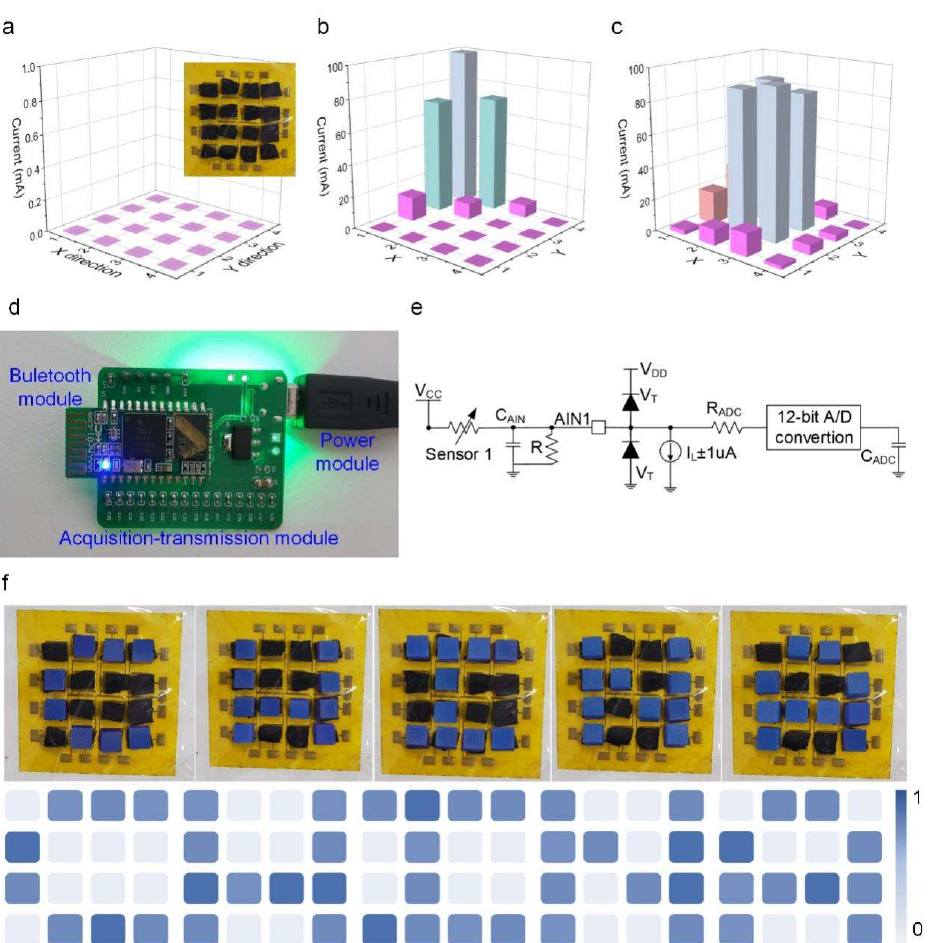
Figure 5. ( a ) The initial response of the 16-pixel pressure sensor array. ( b,c ) The current response of the pressure sensor array when pressed upon different positions on the device. ( d ) The physical diagram of the printed circuit board. ( e ) Block diagram of the readout circuit. ( f ) Different pressure graphics: physical map and terrain recognition normalized demonstration